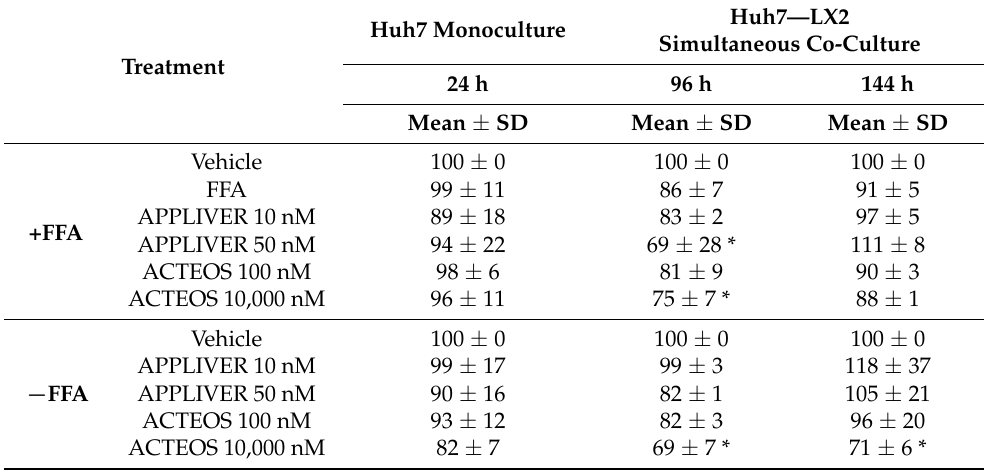
Table 1. Cell viability after APPLIVER and ACTEOS exposure with or without FFA (% vs. vehicle).